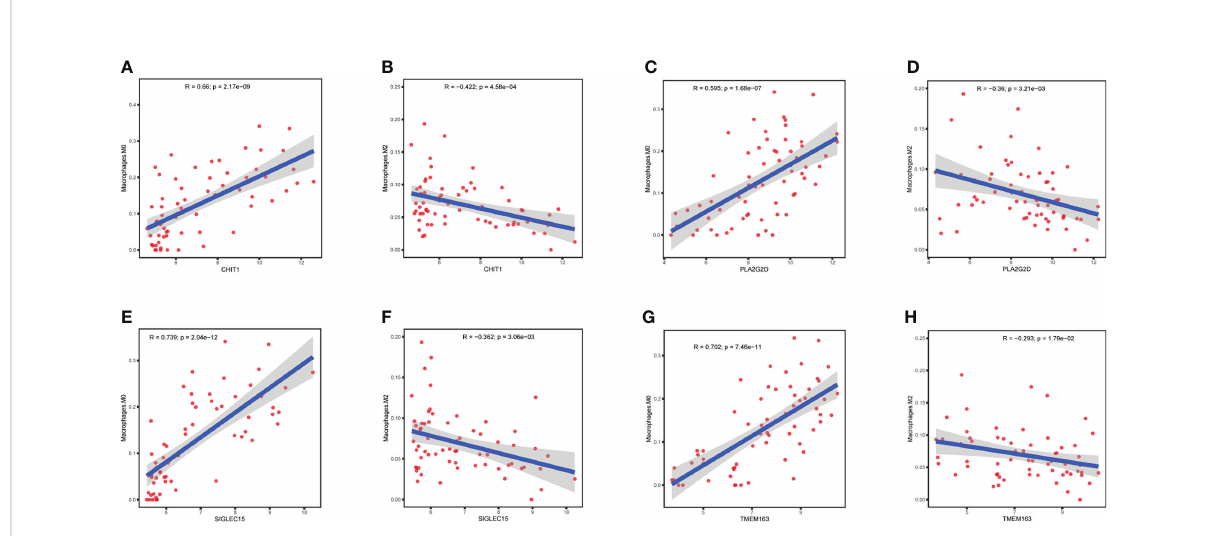
FIGURE 5 Correlation of differential genes with in fi ltration of macrophage in NHL patients (A, B) Correlation of CHIT1 with in fi ltration of macrophage M0 and M2 in NHL patients. (C, D) Correlation of PLA2G2D with in fi ltration of macrophage M0 and M2 in NHL patients. (E, F) Correlation of SIGLEC15 with in fi ltration of macrophage M0 and M2 in NHL patients. (G, H) Correlation of TMEM163 with in fi ltration of macrophage M0 and M2 in NHL patients..